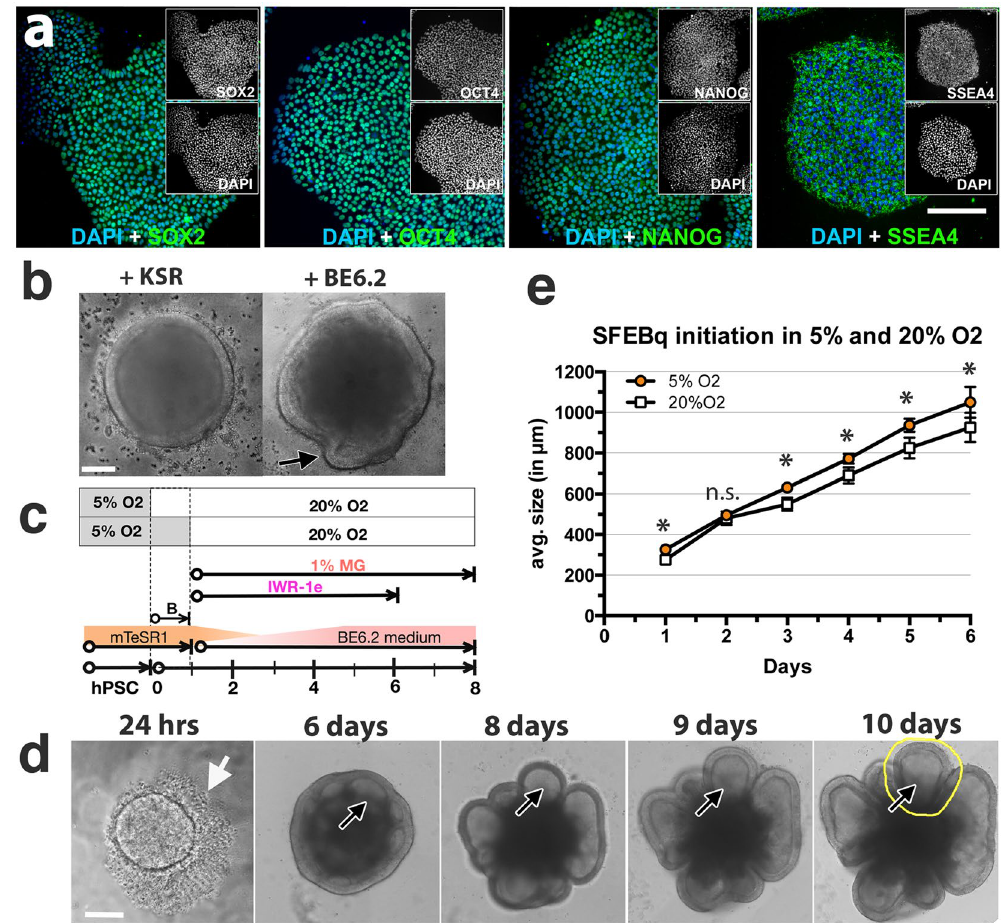
Figure 1. Aggregation of stem cells under hypoxia. ( a ) Pluripotency of IMR90.4 iPSCs confirmed by expression of SOX2, OCT4, NANOG and SSEA4. ( b ) Forced aggregates at day 5 (D5) grown in KSR based neural induction medium (NIM) or BE6.2 medium based NIM in 20% O 2 . Arrow in the BE6.2 sample indicates early vesicle formation. ( c ) Diagram illustrating the approach used to study 1-day recovery and aggregation of dissociated PSCs in 5 or 20% O 2 followed by 20% O 2 . ( d ) A time-lapse sequence of images taken after 24 hours and from D6-10 illustrating initiation and elaboration of individual vesicles (see dark arrows). In yellow is a typical region selected for manual excision. ( e ) Forced aggregates (n = 15 per time point) in 5% and 20% O 2 imaged at daily increments, measured along their radial diameter and quantitated. Average diameters plotted as a function of days in culture and statistical significance determined using the student t-test with Holm-Sidak method. * Statistically significant (p < 0.05), n.s. = not significant. Scale bars ( a ) = 200 μ m; ( b , d ) = 300 μ